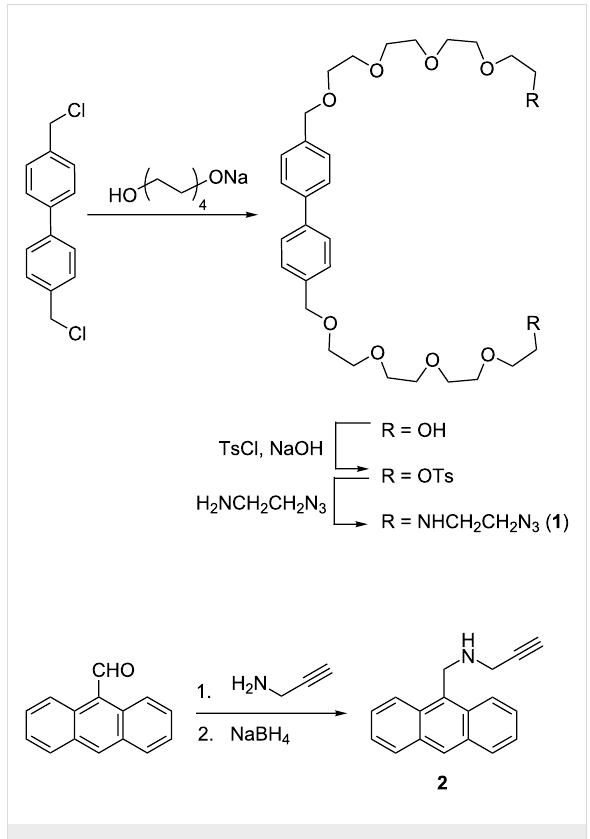
Scheme 1: Synthesis of the axle and stopper building blocks 1 and 2